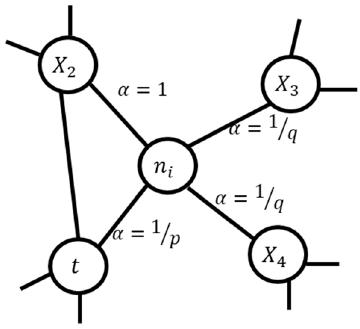
Figure 2. Illustration of the Node2Vec node embedding algorithm [30].